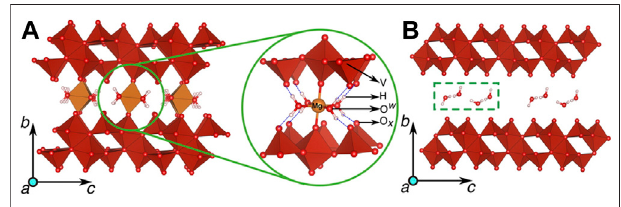
FIGURE 5 | Structures of the fully magnesiated (xMg (cid:2) 0.5) and the fully demagnesiated Xerogel, with 1 H 2 O per formula unit of V 2 O 5 are displayed in (A) and (B) respectively. The coordination of each Mg by 4 Ow can be observed in the enlarged image in the green circle, with the dashed blue lines indicating hydrogen-bonding between the water molecules and the lattice oxygen. The atomic species in the Xerogel structure are labelled in the enlarged image with Ow and Ox indicating the water and lattice oxygen, respectively. Reprinted (adapted) with permission from Nano Lett. 2016, 16, 4, 2426 – 2431. Copyright 2016 American Chemical